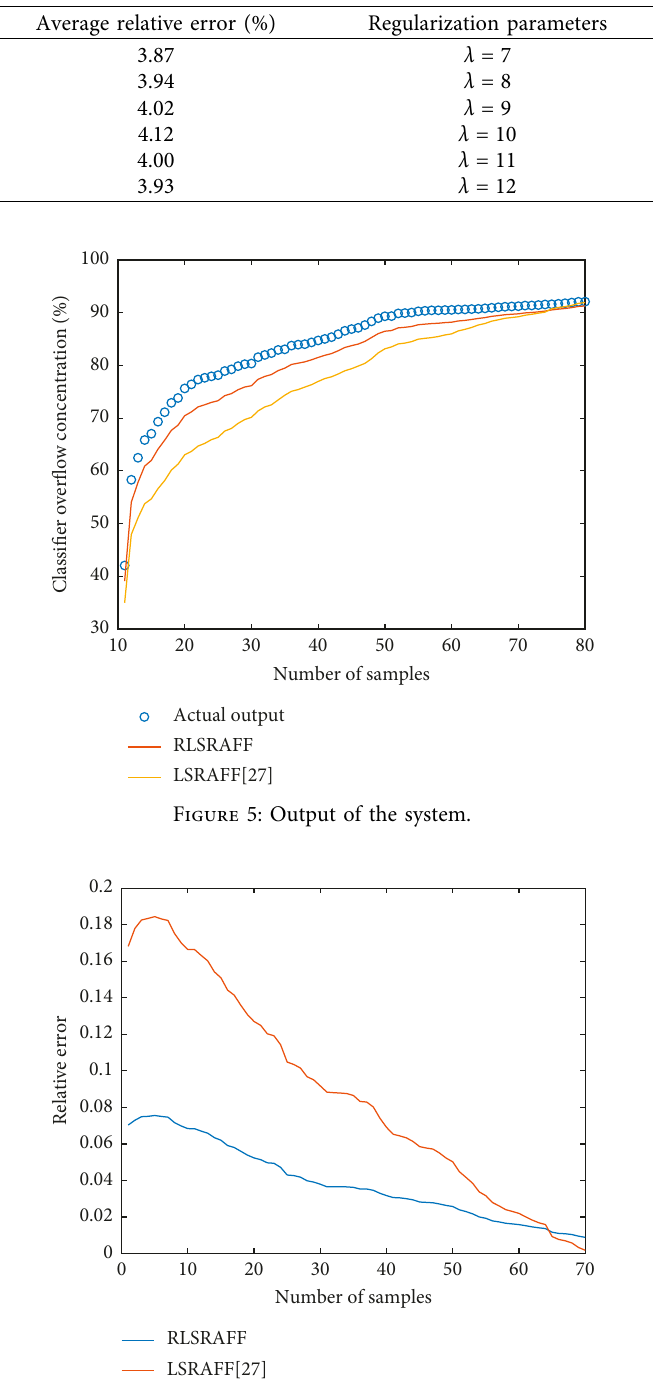
Figure 6: The relative error of the RLSRAFF method and the LSRAFF method